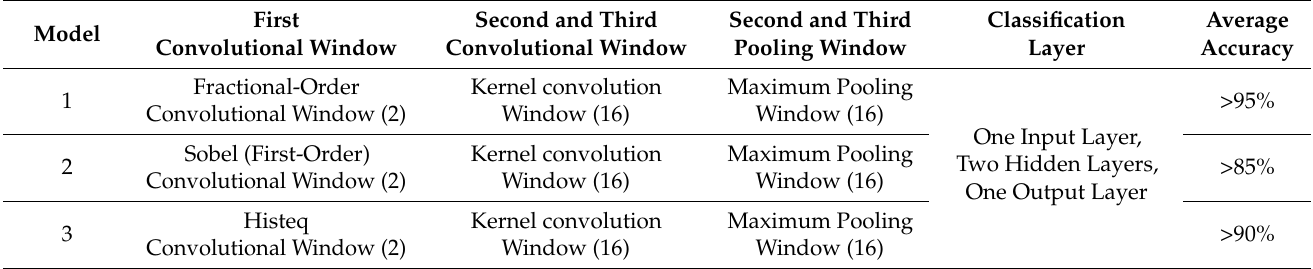
Table 14. Comparisons of average accuracy (%) for the CNN-based classifier with different convolu- tional windows in first to third convolutional